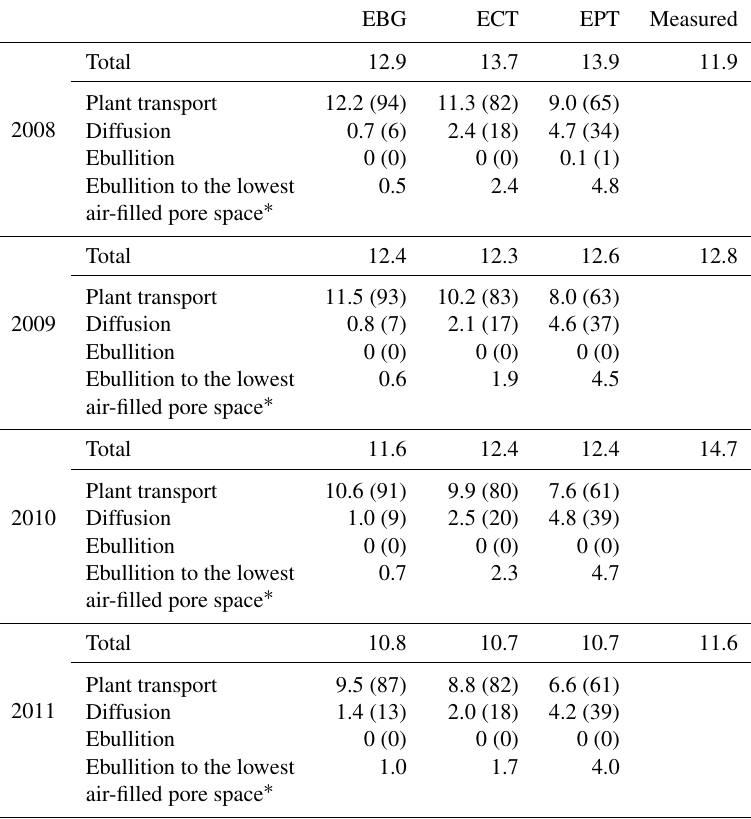
Table 2. Annual CH 4 emissions (g(CH 4 ) m − 2 yr − 1 ) estimated with the HIMMELI model using different ebullition modules and measured with eddy covariance. Values in parentheses show the relative contribution (%) of each CH 4 emission pathway to the total annual emission estimate. EBG ECT EPT